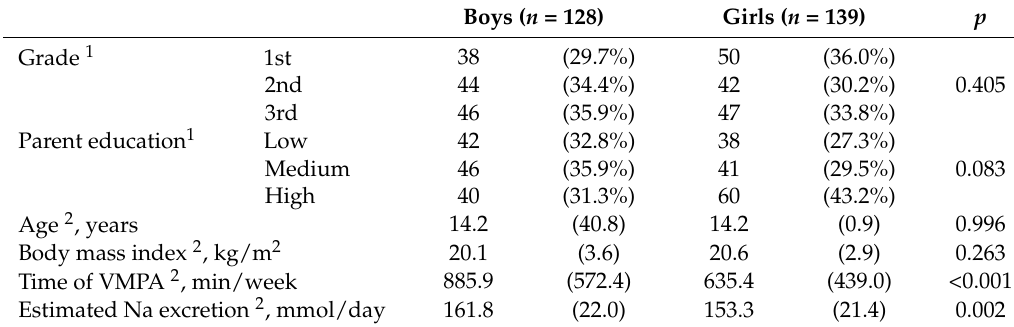
Table 2. Characteristics of the subjects.